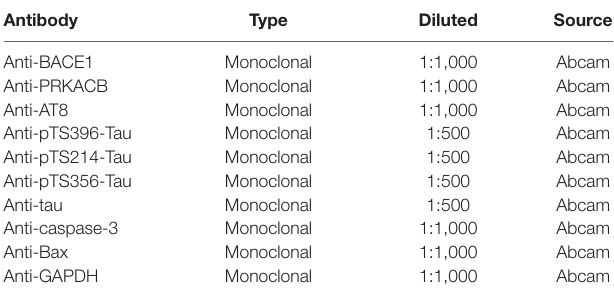
TABLE 3 | Primary antibodies used in this